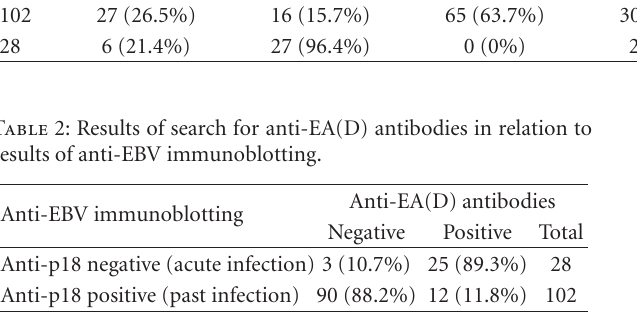
Table 1: Antibody specificity at EBV immunoblotting in 103 samples with an isolated VCA IgG pattern at ELISA screening. No.